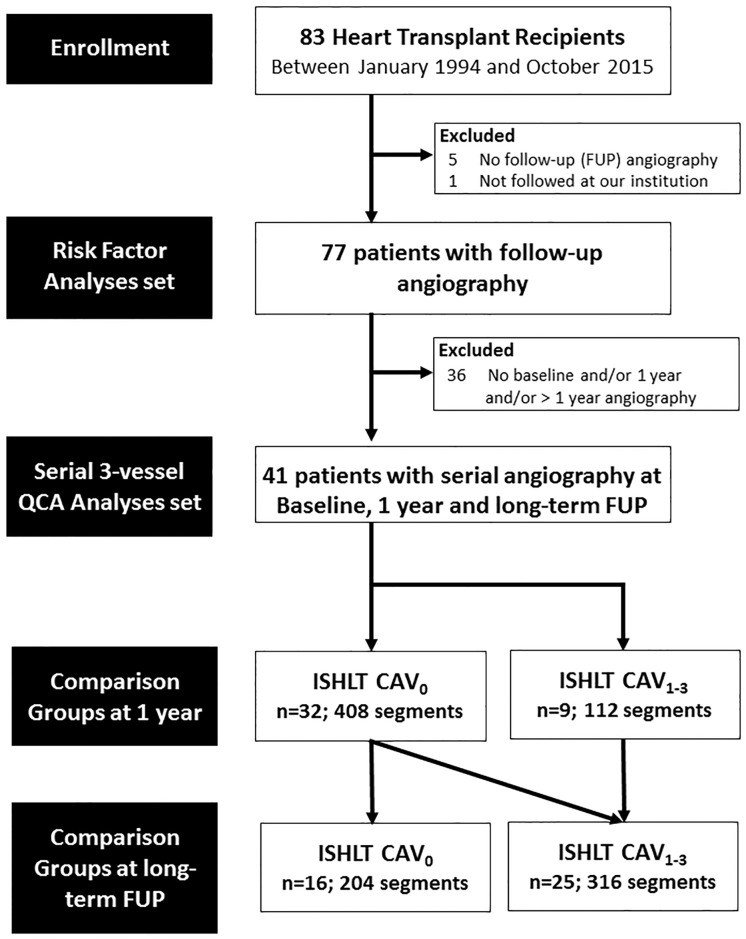
Flow chart.CAV indicates cardiac allograft vasculopathy; FUP, follow-up; QCA, quantitative coronary angiography; ISHLT, International Society of Heart and Lung Transplantation.